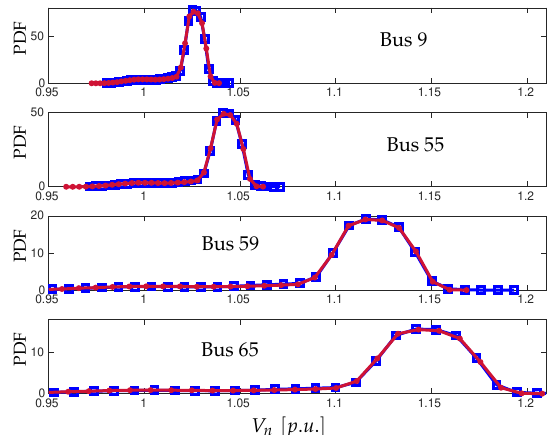
Figure 6. PDF ( V n ) at Buses {9, 55, 59, 65} along the feeder: (Square blue marker) computed with MC; (Dot red marker) computed with PWL method.